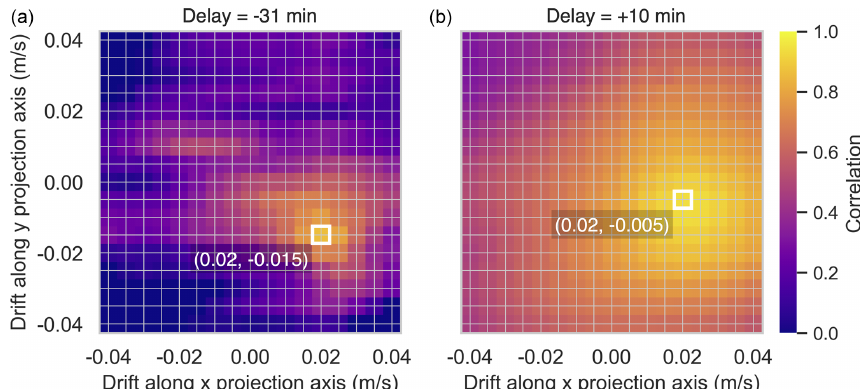
Figure 3. Evaluation of sea ice drift correction for two different airborne laser scanner (ALS) data frames from (a) 31min before the rendezvous point and (b) 10min after. The Pearson correlation between ALS and ICESat-2 segment elevations for applied sea ice drift in steps of 0.005ms − 1 in the x and y directions of the polar stereographic projection. White squares highlight sea ice drift in the x and y directions, where the maximum correlation between ALS and ICESat-2 segment elevations is